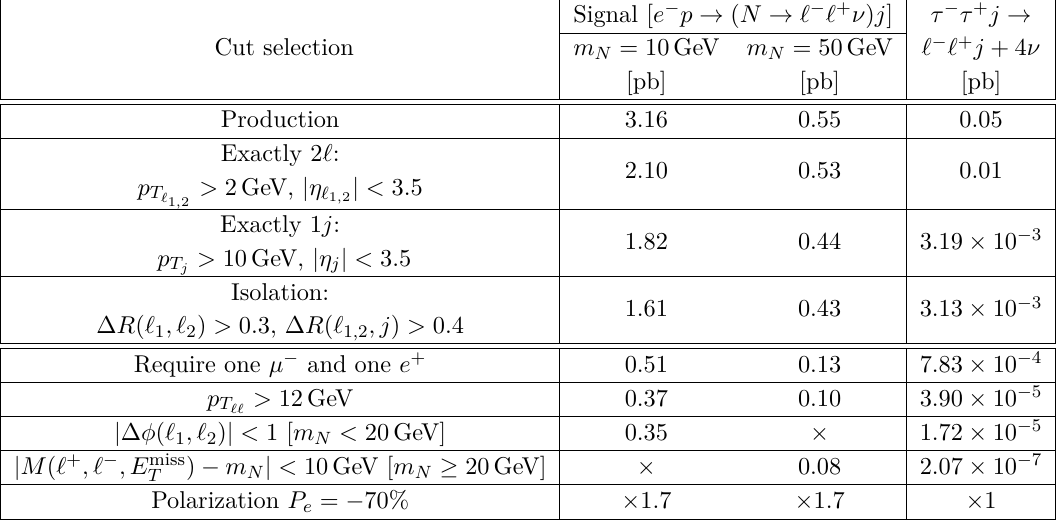
Table 3 . Cut-flow table of the Majorana HNL signal, with | U e | 2 = 1 in the µ − e + j + E miss